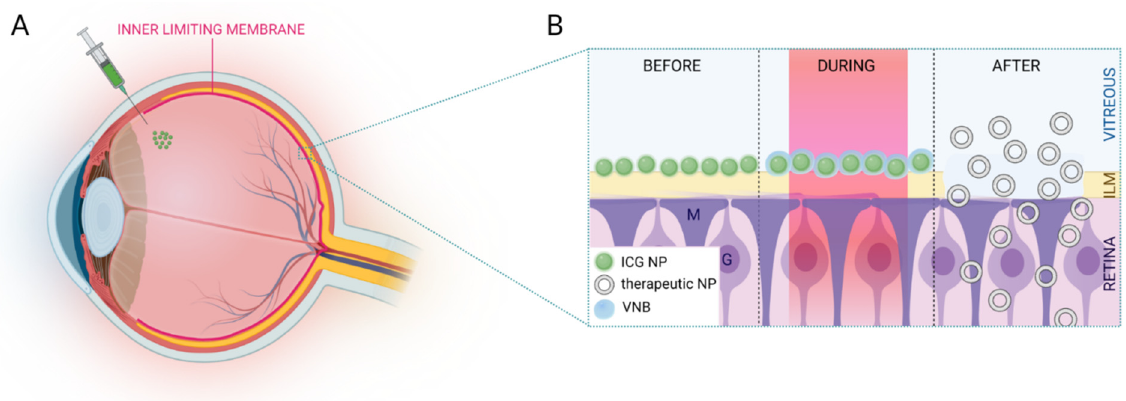
Figure 1. ( A ) Schematic overview of IVT injection of ICG NPs. ( B ) After migration through the vitreous, ICG NPs accumulate at the level of the ILM. Application of high intensity laser pulses results in VNB formation. Upon collapse of these VNBs, mechanical effects can disrupt the ILM paving the way for therapeutics to enter the retina. Image created with BioRender.